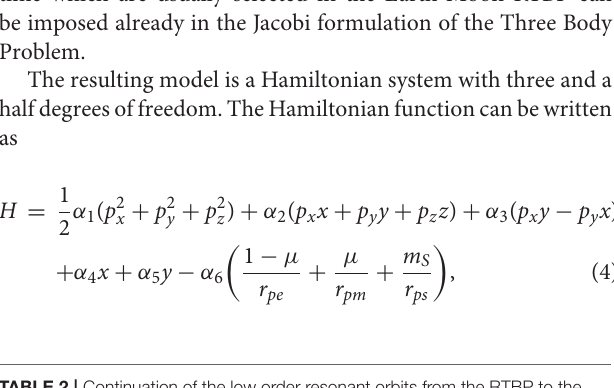
TABLE 2 | Continuation of the low order resonant orbits from the RTBP to the QBCP.